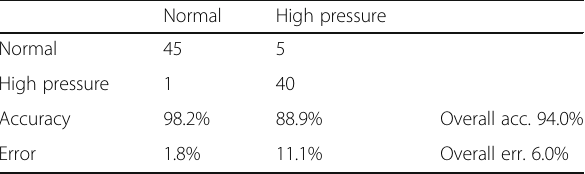
Table 7 Test confusion matrix for neural network with three features (MRL, contour area, and contour height) Normal Normal